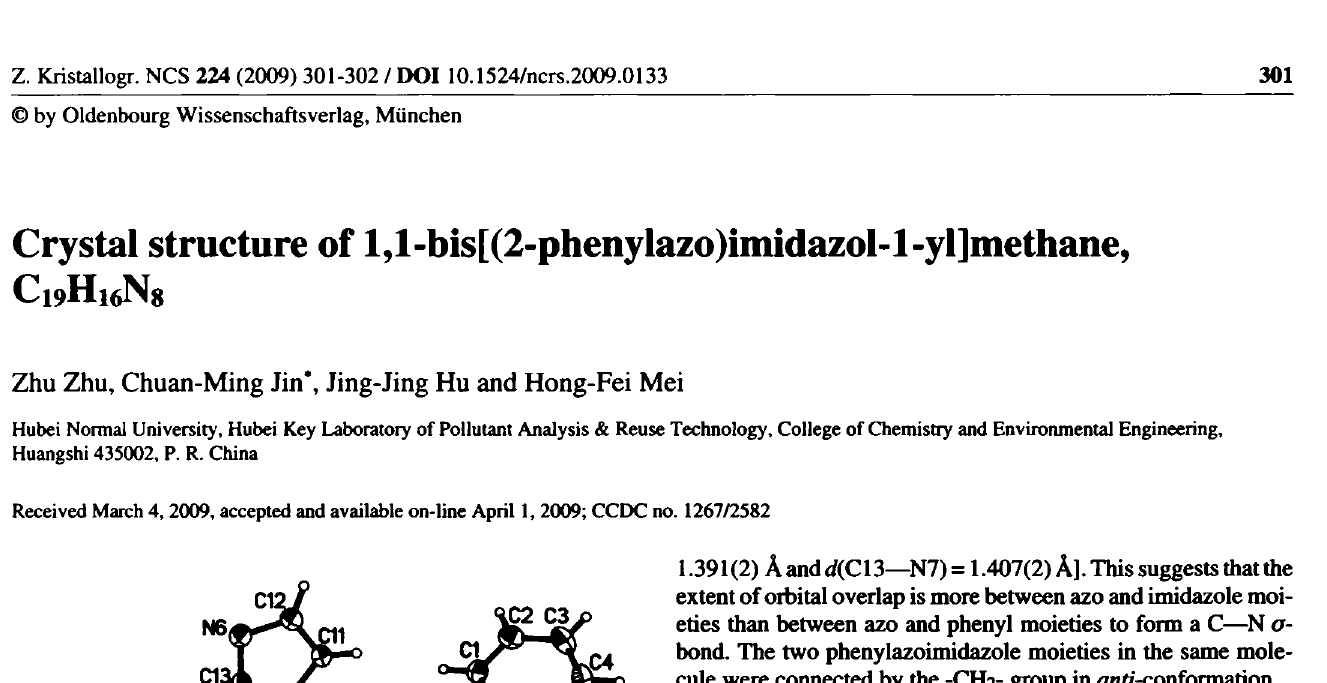
Table 1. Data collection and handling.